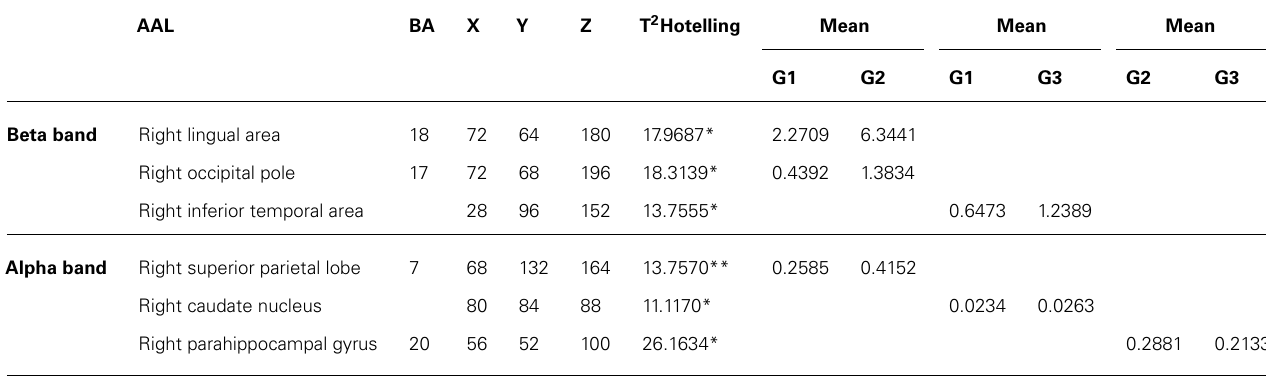
Table 3 | Summary of significant differences between groups with respect to maximal intensity projection areas during word memorizing list.